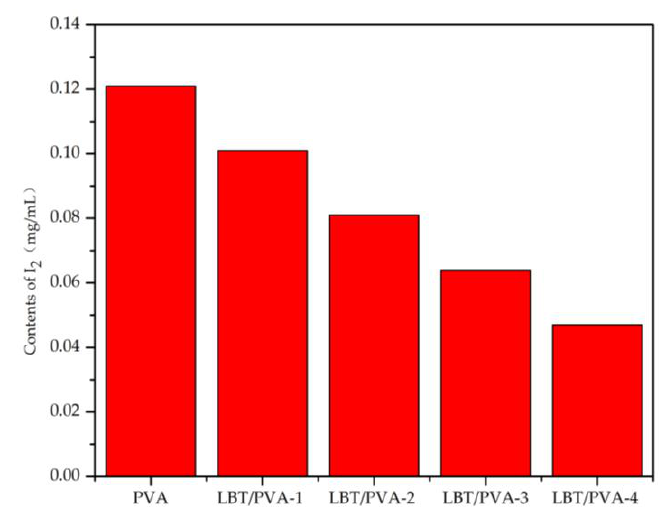
Figure 4. The effect of tannin content in the composite membrane on the amount of I 2.